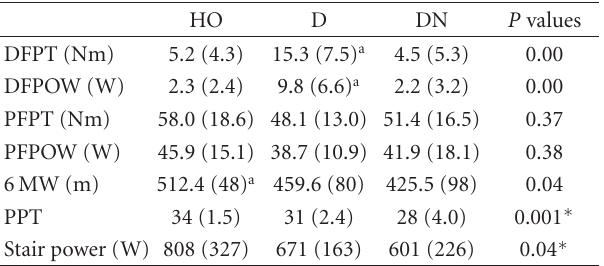
∗ Indicates all 3 groups are di ff erent. a Indicates that the group is di ff erent from the other 2 groups. DFPT: dorsiflexor peak torque; DFPOW: dorsiflexor power; PFPT: plan- tarflexor peak torque; PFPOW: plantarflexor power; 6MW: six-minute walk distance; PPT: physical performance test (9